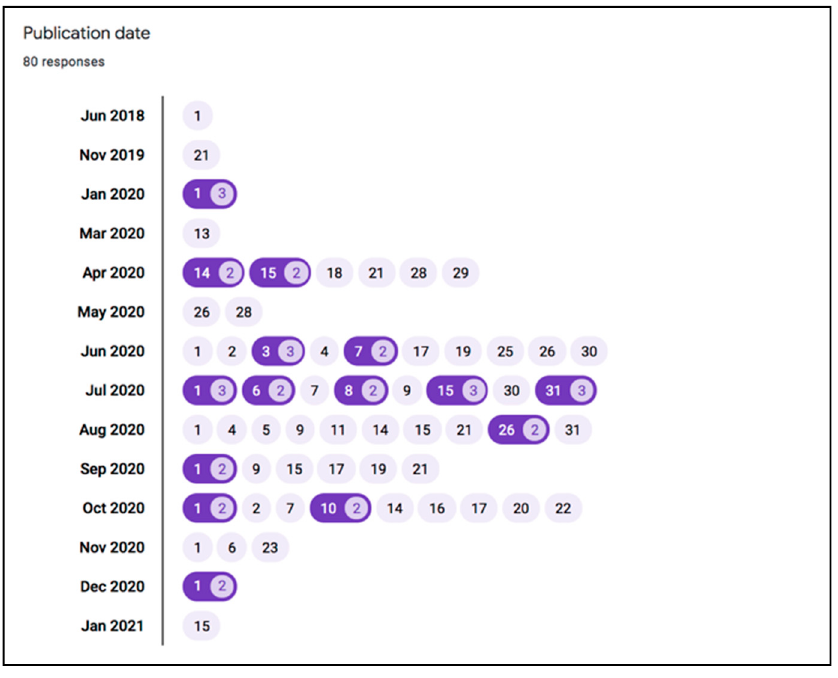
Figure 2. Literature time frame .